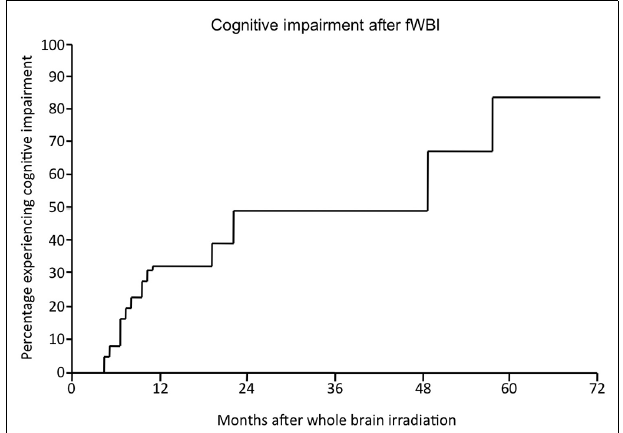
FIGURE 2 |The percentage of patients developing radiation-induced cognitive impairment as a function of time after fWBI. Adapted from Nieder etal.